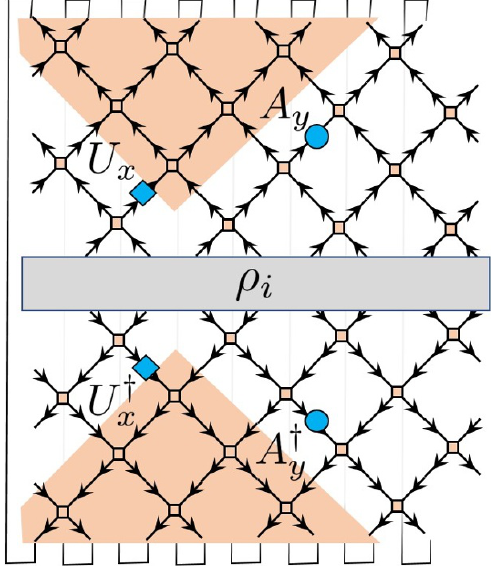
Figure 9 . In the Trotter network, CI( x : y ) = 0 unless y is in the future light cone of x